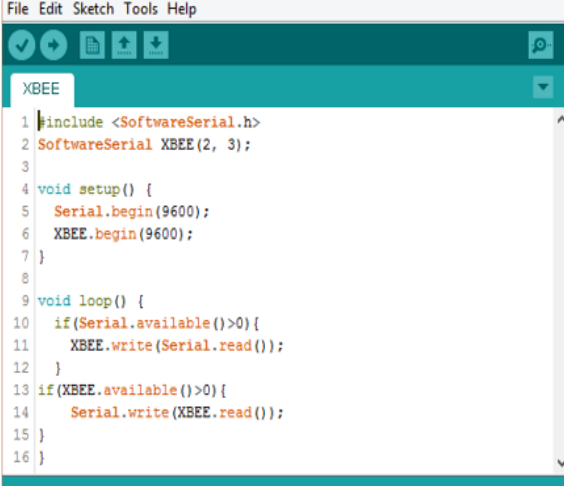
Figure 8. Code for ZigBee in Arduino UNO R3